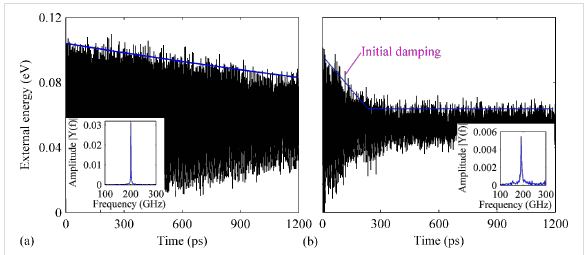
Figure 9: Variation over time of the external energy of the defective GNR with four vacancies and B-dopant densities of (a) 0.76% and (b) 2.40%. The insets show the corresponding frequency spectra.